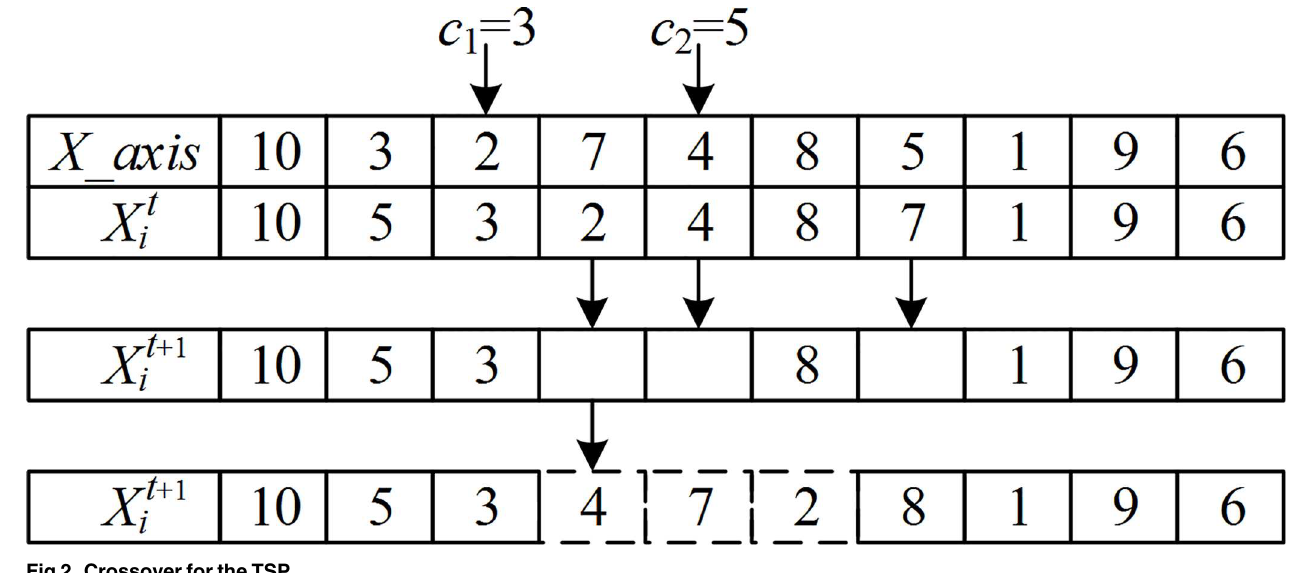
Fig 2. Crossover for the